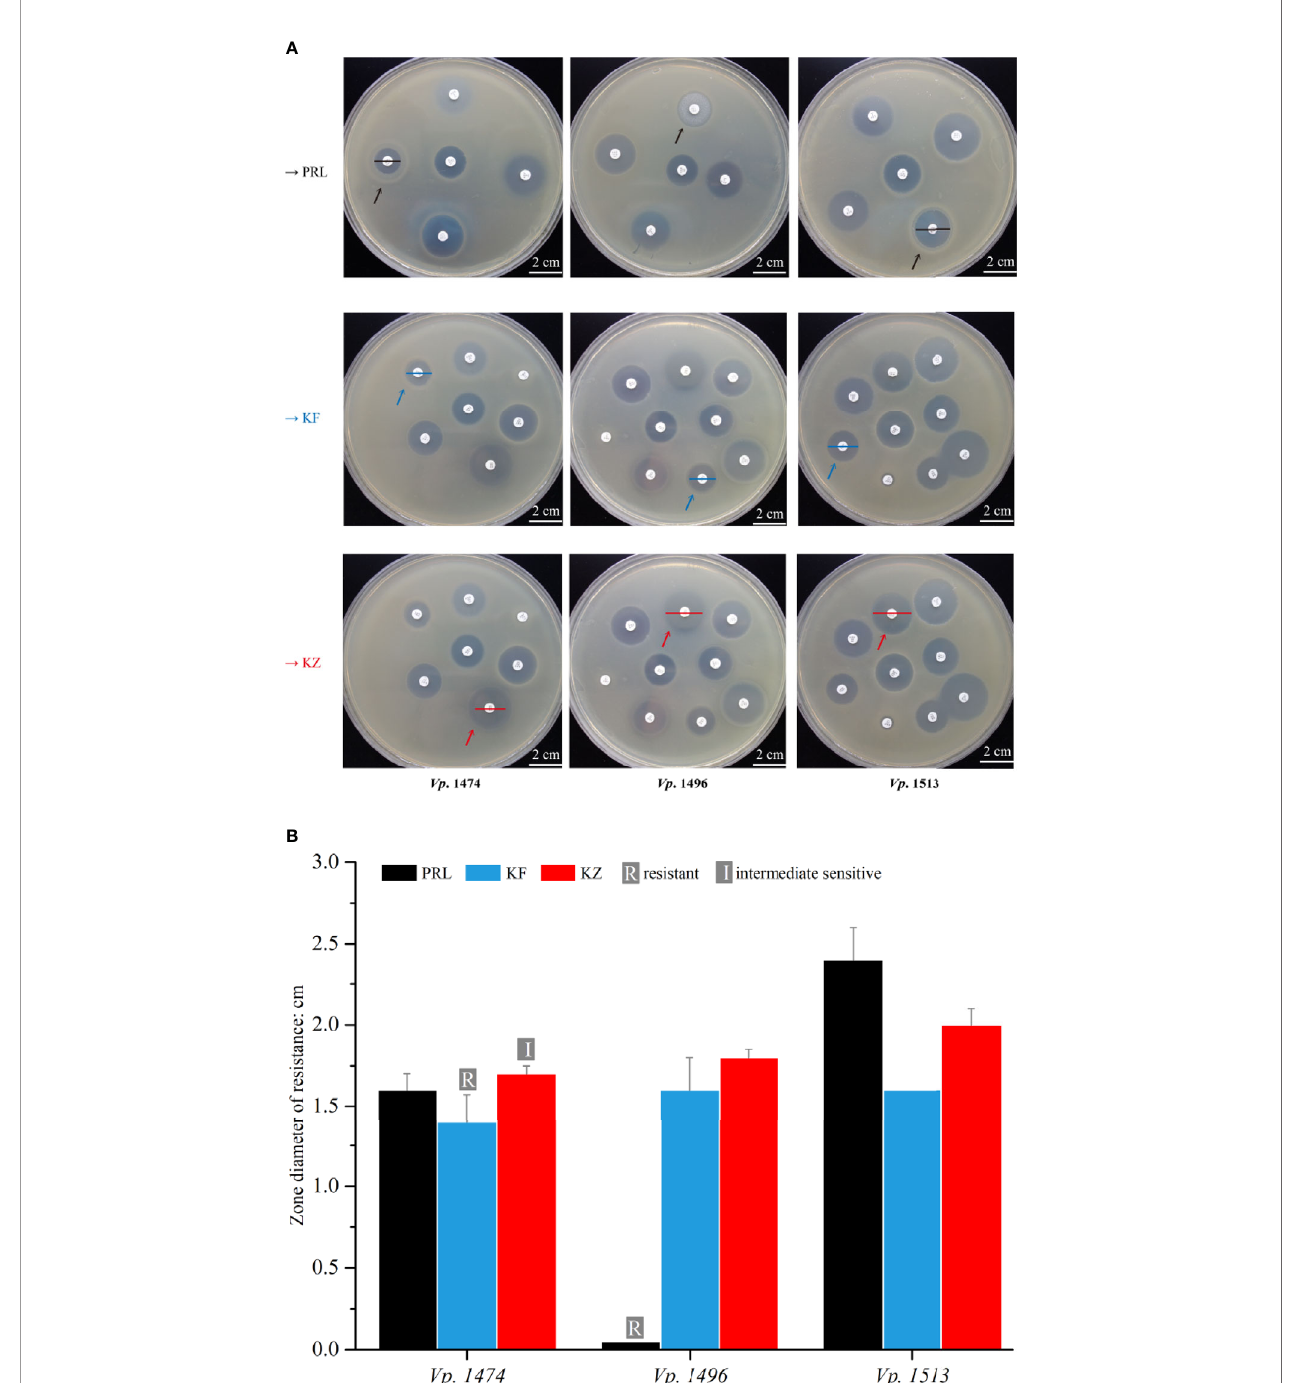
FIGURE 9 | Antibiotic resistance analysis of mice infected by V. parahaemolyticus strains Vp. 1474, Vp. 1496, and Vp. 1513. (A) Representative results of antimicrobial susceptibility test using Kirby-Bauer method. Black arrow: paper position of piperacillin (PRL) on the representative plates; blue arrow: paper position of cephalothin (KF) on the representative plates; red arrow: paper position of cephazolin (KZ) on the representative plates; black line: zone diameter of V. parahaemolyticus strains resistant to PRL; blue line: zone diameter of V. parahaemolyticus strains resistant to KF; red line: zone diameter of V. parahaemolyticus strains resistant to KZ. (B) Statistical histogram of antibiotic resistance to PRL, KF, and KZ for the three strains. For PRL, the zone diameters for resistant, intermediately sensitive, and sensitive are ≤ 1.7 cm, 1.8 to 2.0 cm, and ≥ 2.1 cm, respectively; for KF and KZ, the zone diameters for resistant, intermediately sensitive, and sensitive are ≤ 1.4 cm, 1.5 to 1.7 cm, and ≥ 1.8 cm,